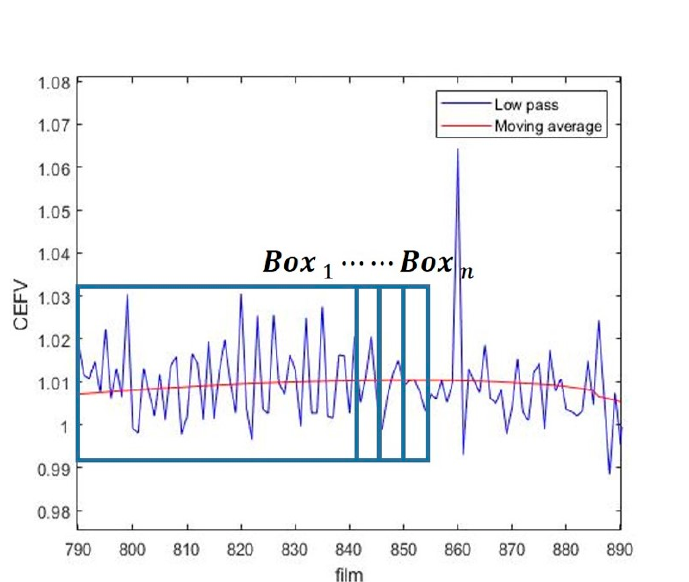
Figure 4. ICMA evolution.